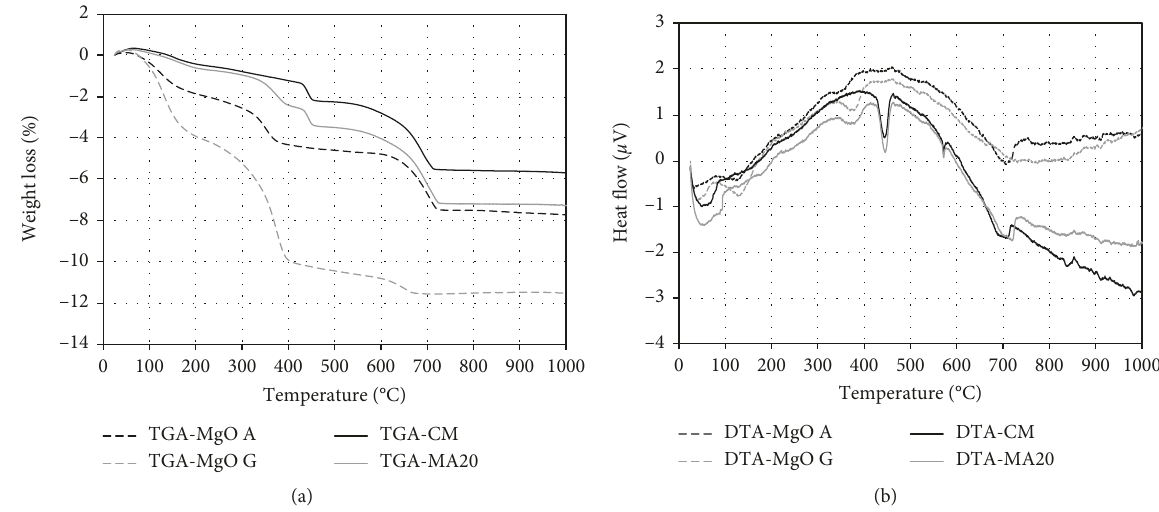
Figure 4: TGA (a) and DTA (b) of the two MgO samples and of the control mortar (CM) and mortar with 20% MgO A